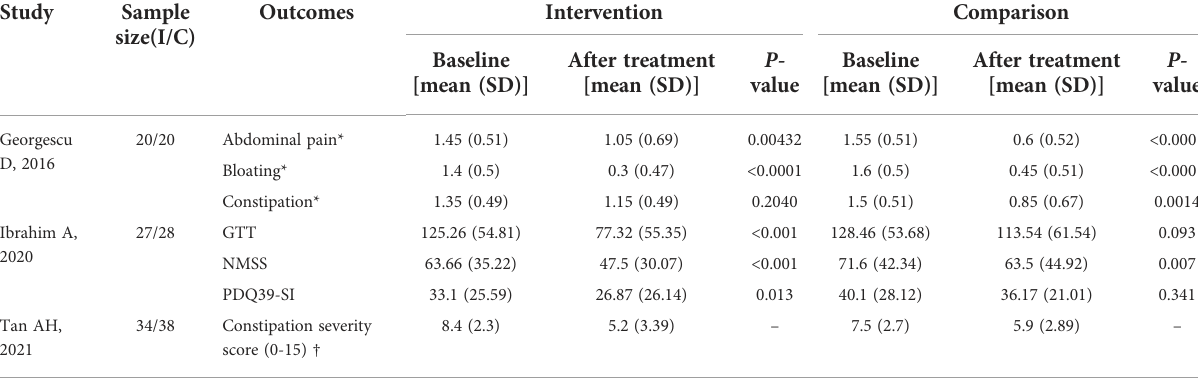
TABLE 2 Summary of the